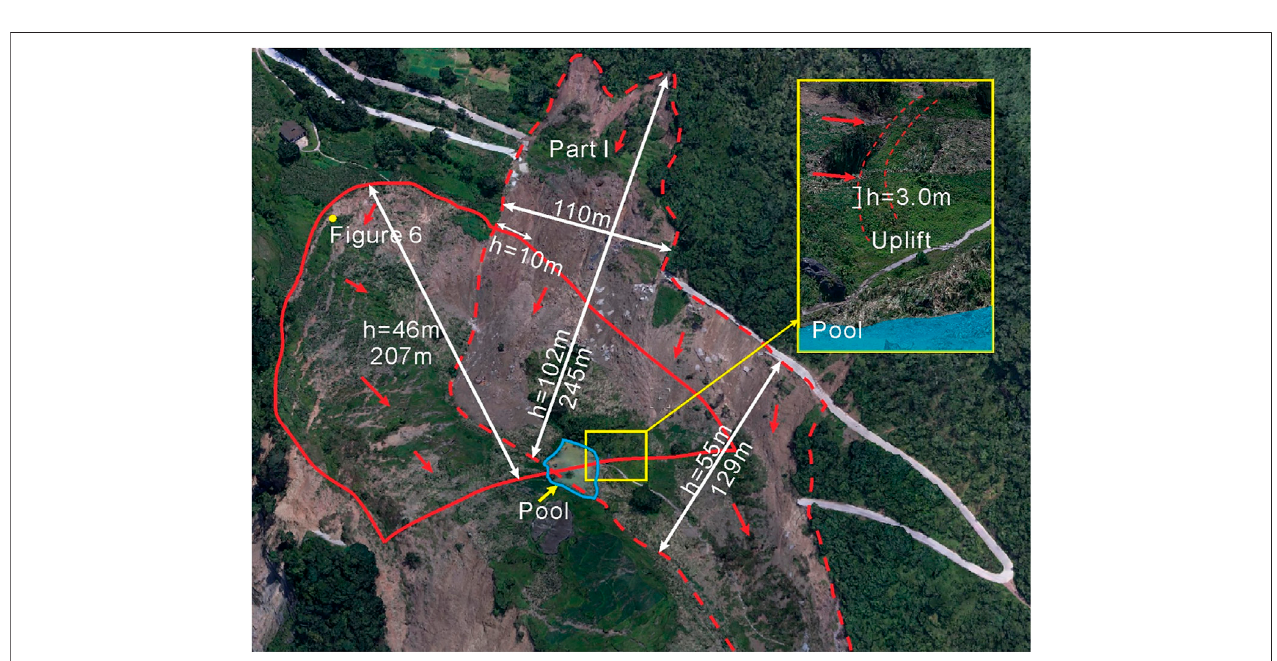
FIGURE 6 | Picture of the source area and Part I area. The sub-picture is the uplift zone between the source area (left) and the transportation area (right). Note, “ h ” represents the elevation difference of the landslide area.